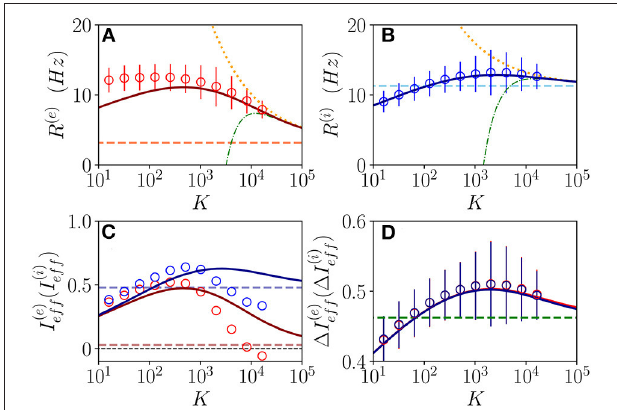
FIGURE 2 | Asynchronous dynamics: Instantaneous population rate R ( e ) ( R ( i ) ) of excitatory (inhibitory) neurons in function of the median in-degree K are shown in (A,B) . The effective input currents I ( e ) eff ( I ( i ) eff ) given by Equations (13) are reported in (C) and the fluctuations of the input currents 1 I ( e ) eff ( 1 I ( i ) eff ), as obtained from Equations (20), in (D) . Red (blue) color refers to excitatory inhibitory population. The solid continuous lines represent the value obtained by employing the exact MF solutions R ( x ) of Equation (8), the dotted (dash-dotted) lines correspond to the first (second) order approximation R ( x ) 0 ε R ( x ) 1 ( R ( x ) 0 ε R ( x ) 1 ε 2 R ( x ) 2 ) and the dashed horizontal lines to the + + + e , i . The circles zeroth-order one R ( x ) 0 in (A,B,D) , and to I ( x ) a in (C) with x = N ( i ) correspond to data obtained from numerical simulations of N ( e ) 10,000 = = N ( i ) neurons for K < 4,096, N ( e ) 20,000 for K 4,096,8,192 and = = = N ( e ) N ( i ) 30,000 for K > 8,192, averaging the population rates over a = = window of T 40 s , after discarding a transient of T 60 s . The error bars in = = (A,B) are obtained as the SD (over the time window T ) of the population rates, while the average CV of neurons is around 0.15 for all the reported simulations. Synaptic couplings and the ratio between the currents are fixed as 1, 1 ( ee ) 0 2.5, and stated in sub-section 3.1, other parameters are 1 ( ii ) 0 = = I ( e ) 0 0.2. The values of the asymptotic solutions (dashed lines) are : in (A,B) = R ( e ) 0 3.18 Hz and R ( i ) 0 11.28 Hz, respectively; in (C) I ( e ) a 0.0284 and = = = I ( i ) a 0.4623 and 1 I ( i ) eff 0.4791; in (D) 1 I ( e ) eff = = ≃